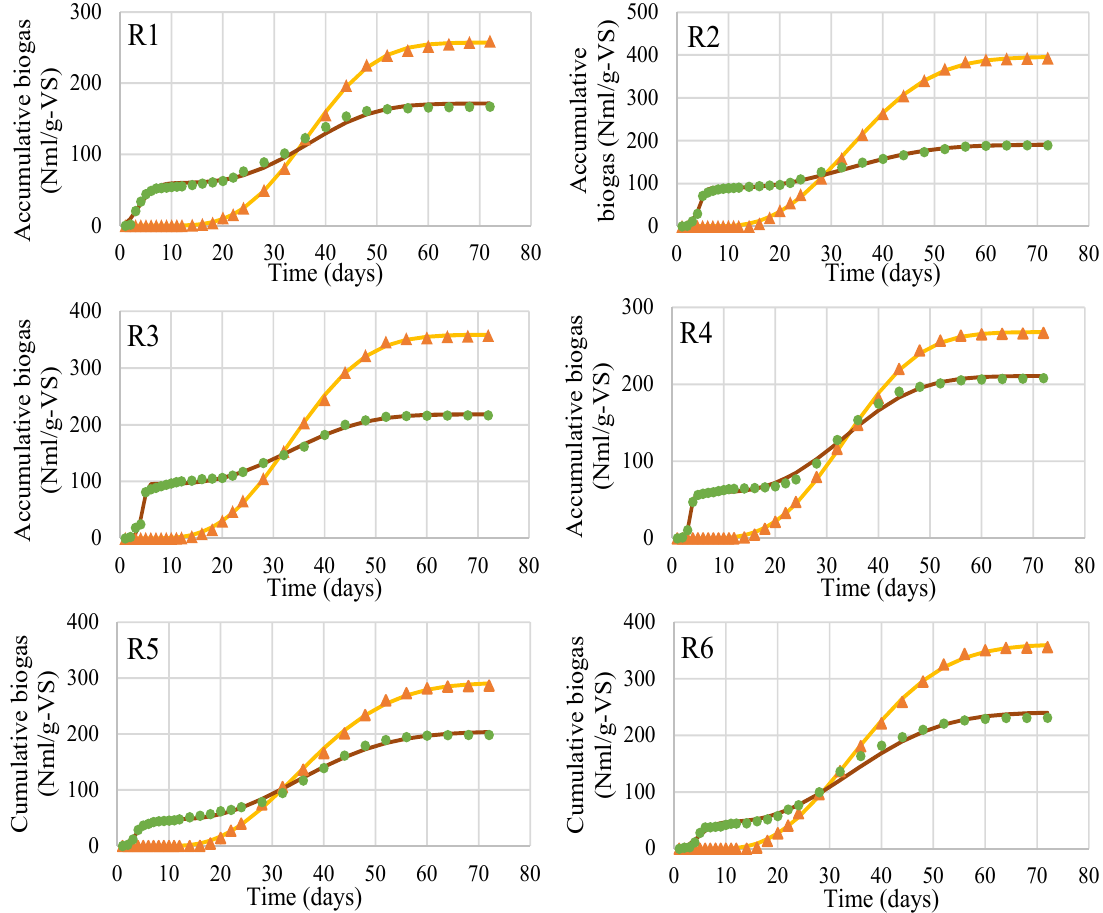
Fig 5: Cumulative carbon dioxide and methane from experiments and modelling (∆ Experimental CH 4 ; ο Experimental CO 2 ; ̶̶̶ ̶̶̶ ̶̶̶ Modeling CH 4 ; ̶̶̶ ̶̶̶ ̶̶̶ Modeling CO 2